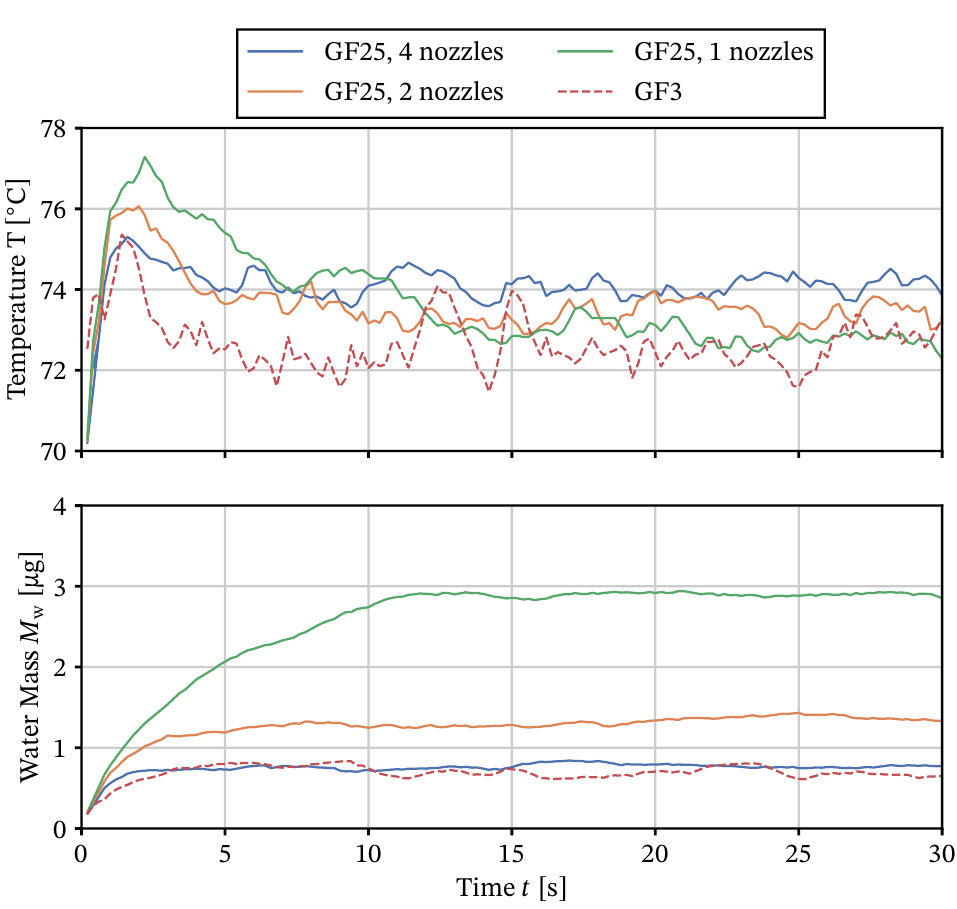
Figure 12. Mean particle temperature and per-parcel water mass over time for the GF25 pilot- scale plant in three nozzle configurations and the GF3 lab-scale plant operated at a spray rate 1 ˙ M spray = ( 8 × ) 15g min −